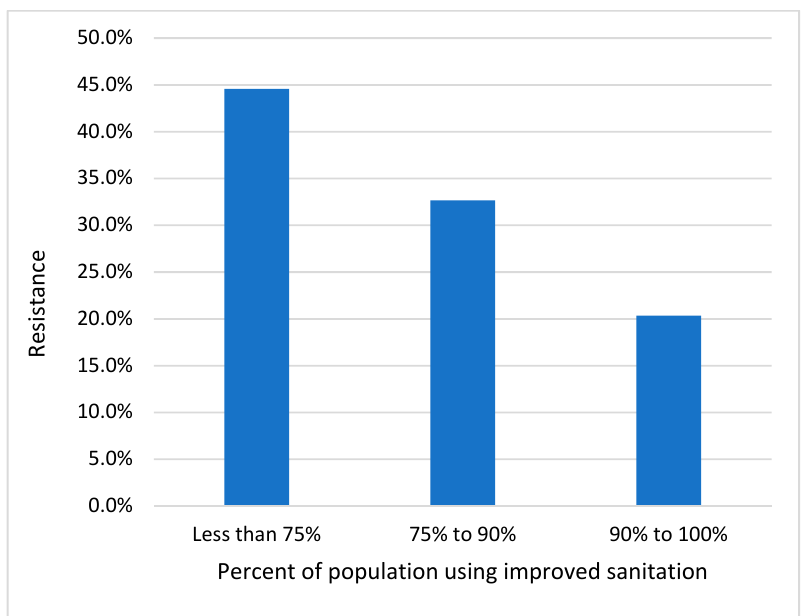
Figure 2. Improved sanitation versus resistance percentage of E. coli to 3rd-generation cephalosporins and fluoroquinolones. Globally, these antibiotic resistance levels are inversely related to usage volumes but strongly related to sanitation levels. Source Data: Collignon et al. (2018) [15] and World Health Statistics, WHO, (2011) [16].